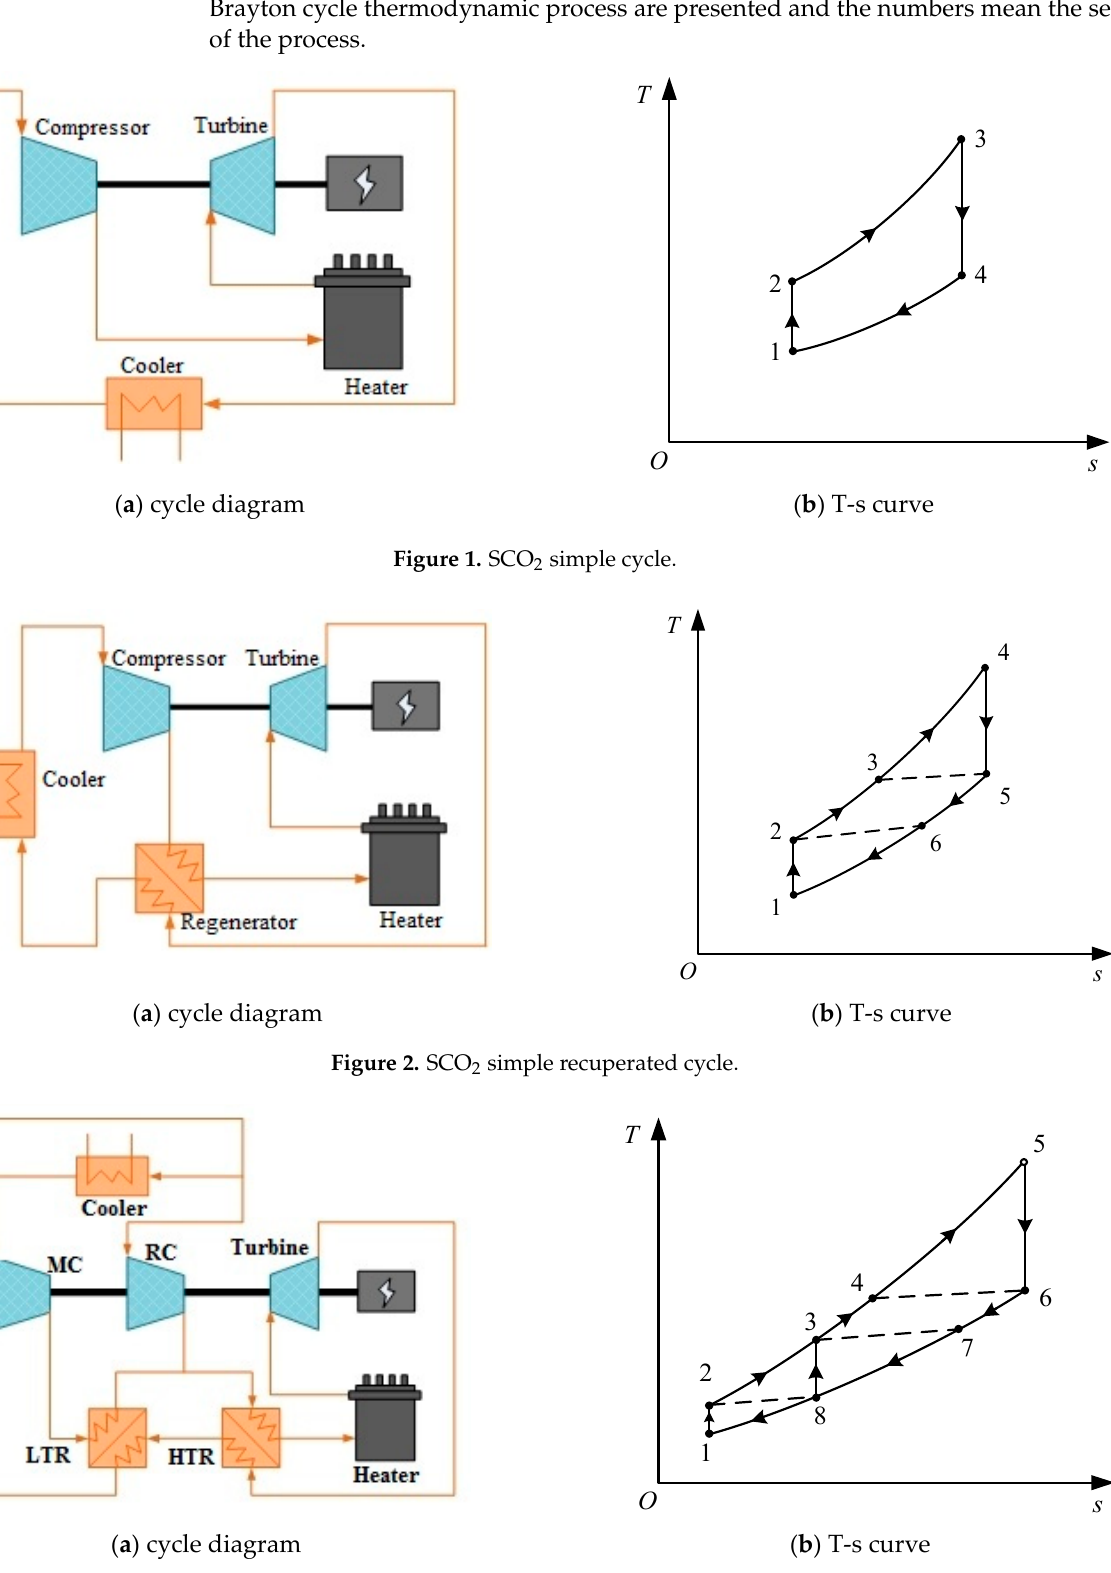
Figure 3. SCO 2 recompression cycle.